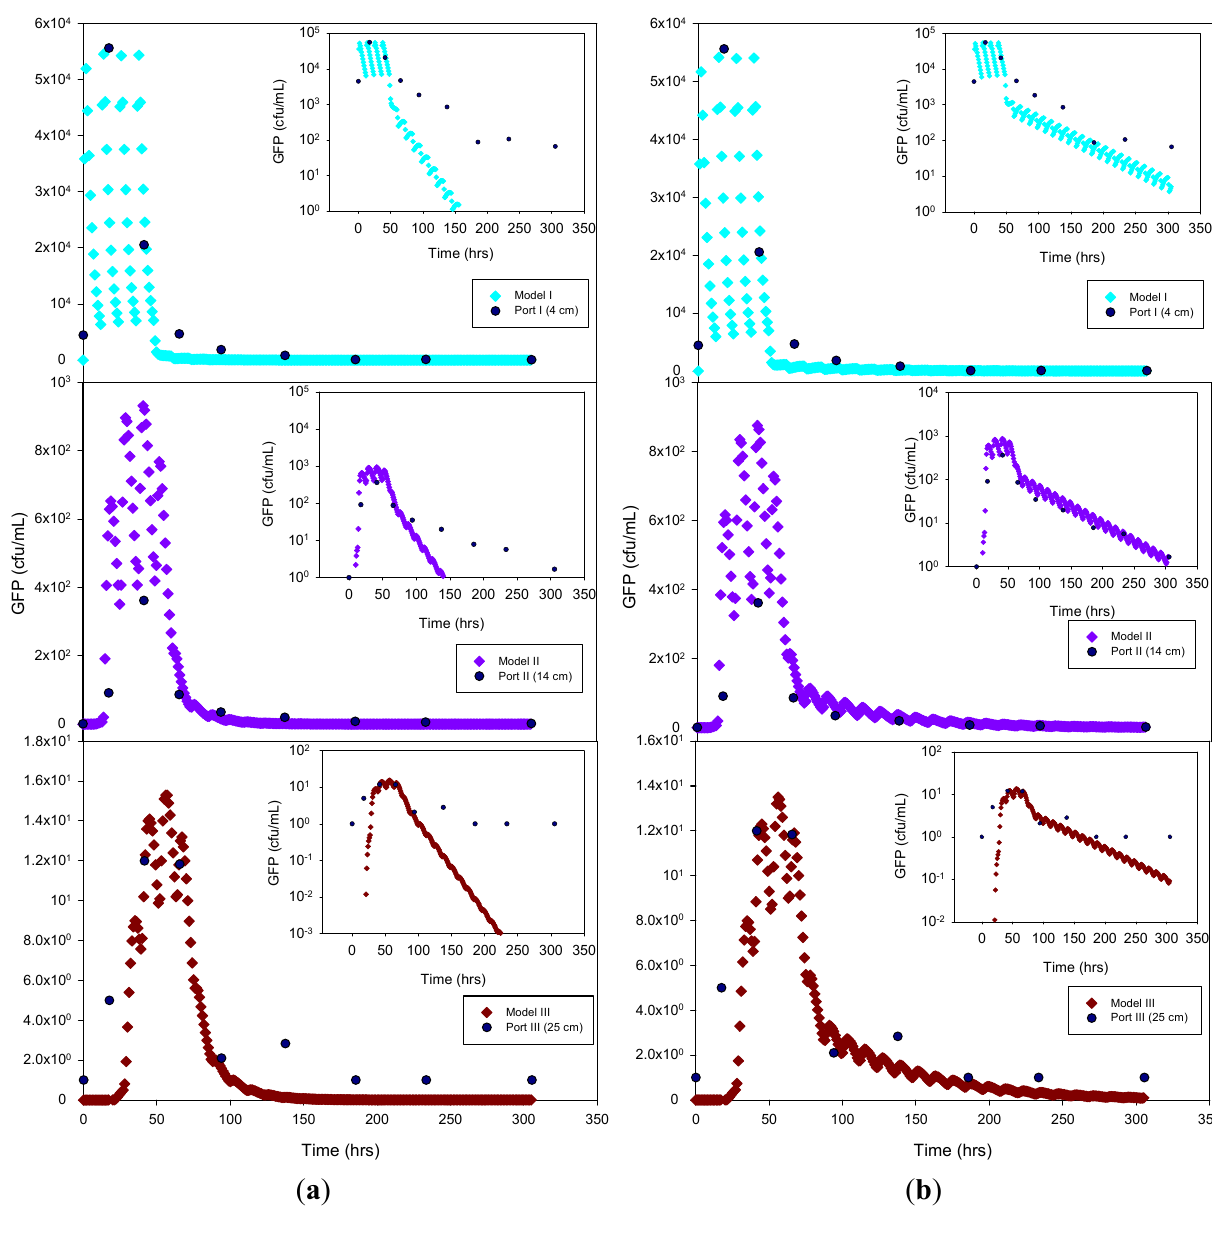
Figure 4. Experimental GFP E. coli data and HYDRUS optimization ( a ) and trial-and-error; ( b ) simulation for the sandy soil at 4 cm, 14 cm and 25 cm depth. The log-normal inserts emphasize the tailing